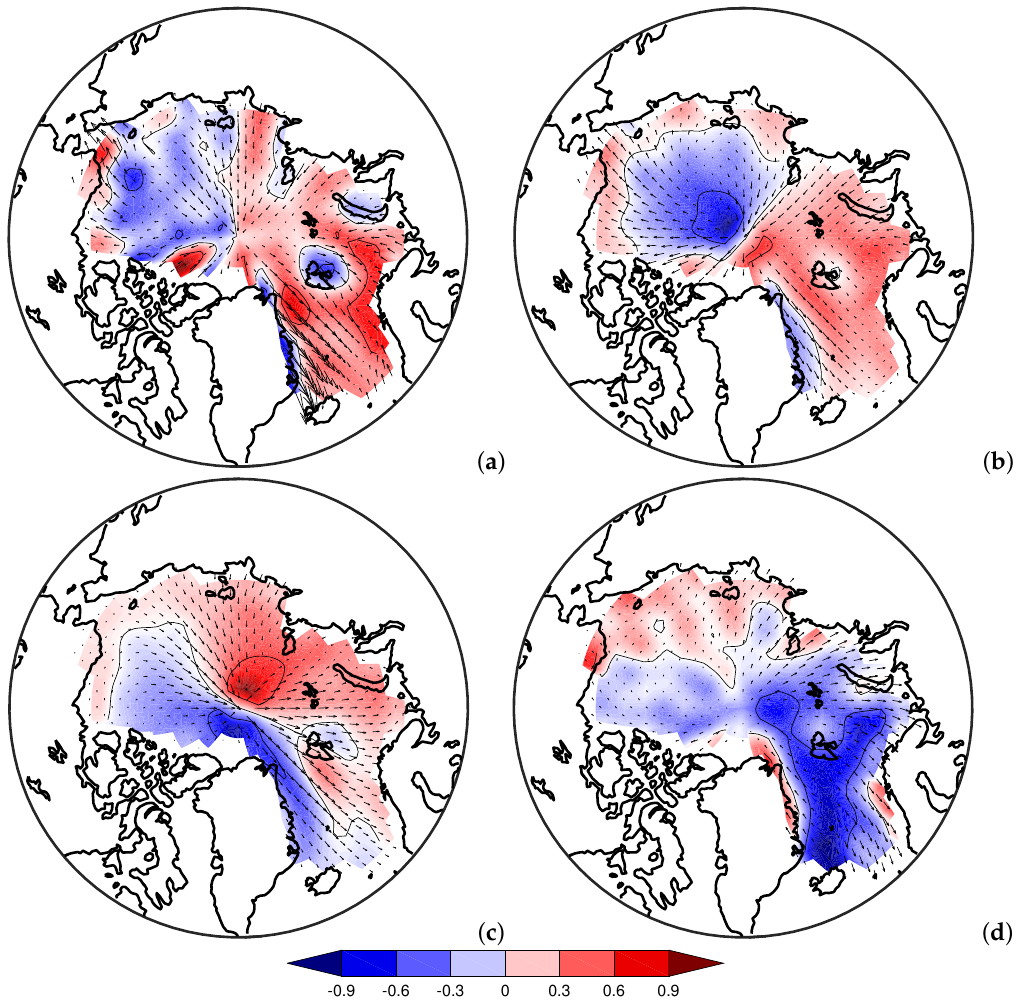
Figure 2. The average value and three eigenfunctions of the surface wind EOF decomposition (arrows) and its vorticity (color and contours): ( a ) averaged from 1948 to 2019 spatial distribution of the wind field, ( b ) the first eigenfunction of the surface wind speed, ( c ) the second, ( d ) the